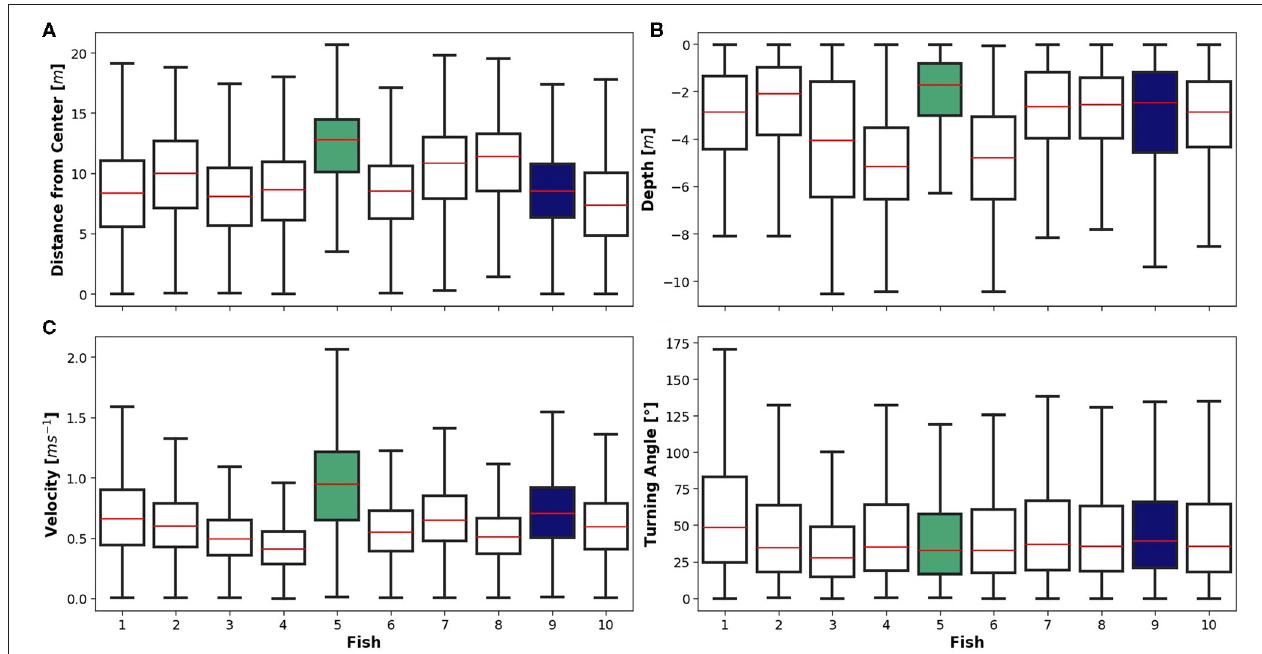
FIGURE 2 | Boxplots of four behavioural variables for individual fish during the study period where the red line is median, box incorporates 25–75th percentile, and error bars mark maxima and minima. Green shaded box represents fish 5 and blue shaded represents fish 9. (A) Distance from centre [m]. (B) Depth [m]. (C) Velocity [ms − 1 ]. (D) Turning Angle [ ◦